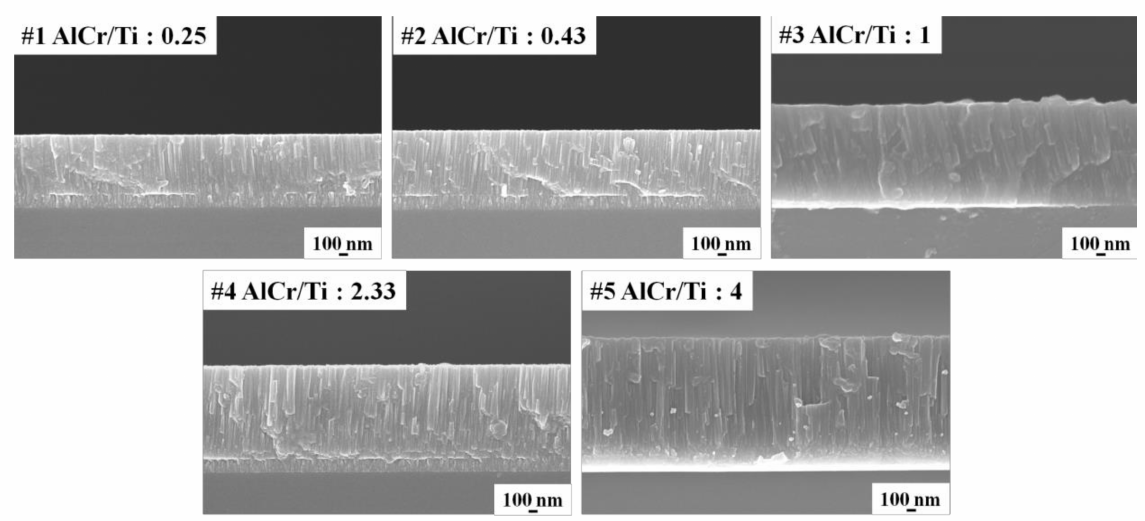
Figure 4. Cross-sectional SEM images of the AlTiCrN coatings deposited under five different input power ratios.